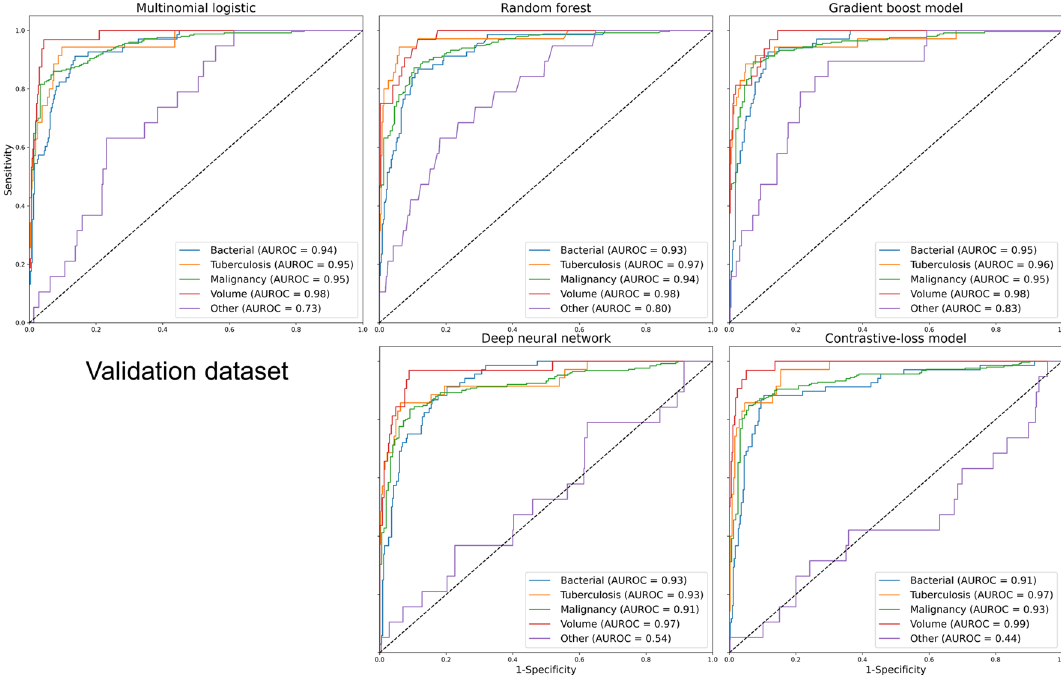
Figure 2. AUROC of each label in the validation dataset. AUROC: area under the receiver operating characteristic.